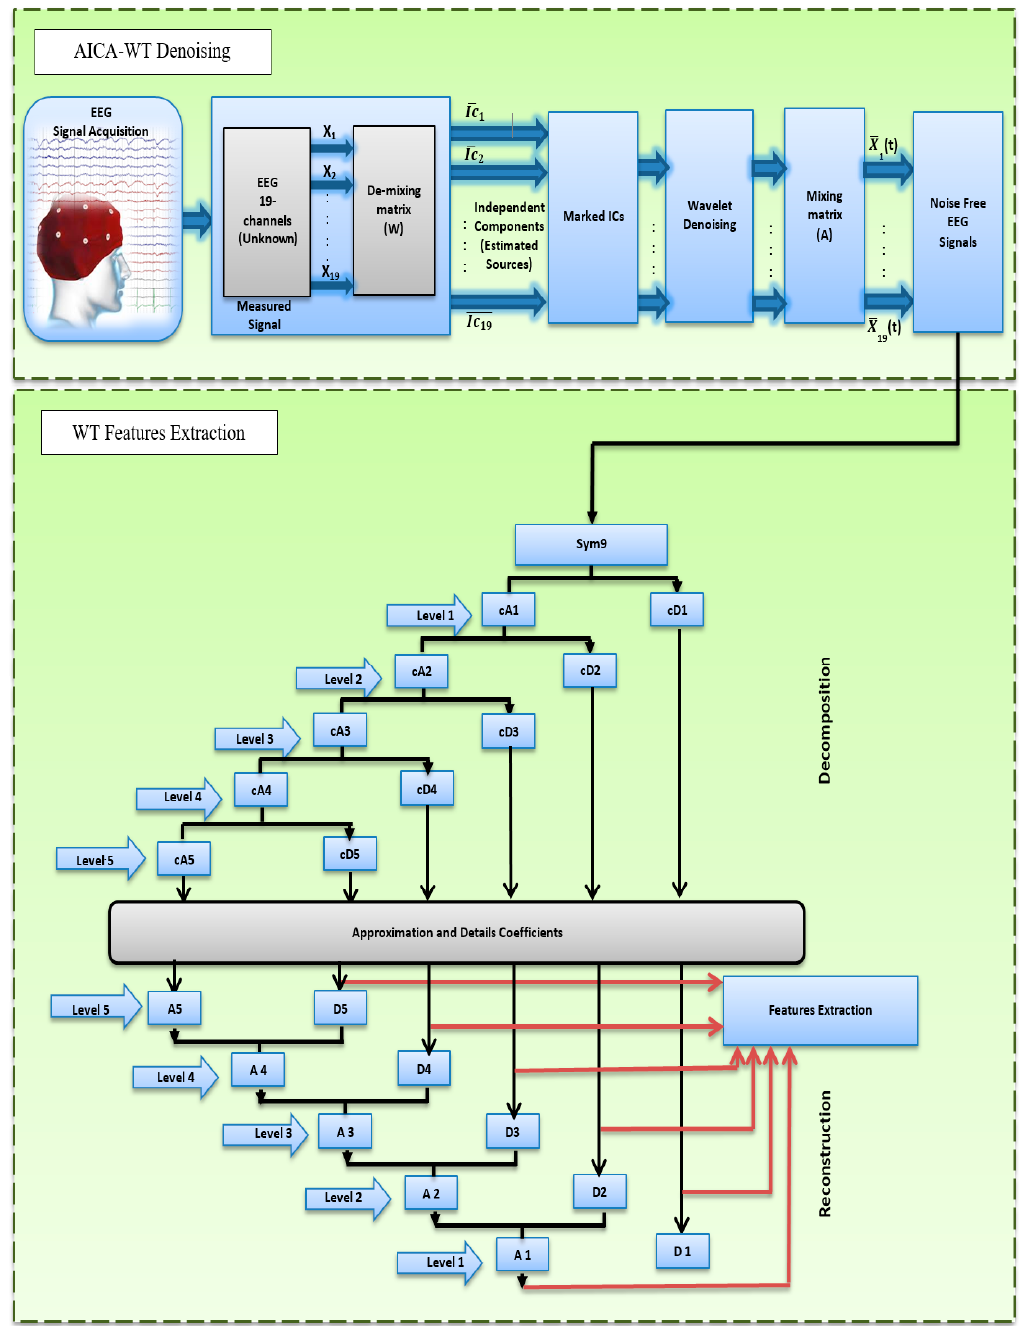
Figure 1. The proposed block diagram of this study.